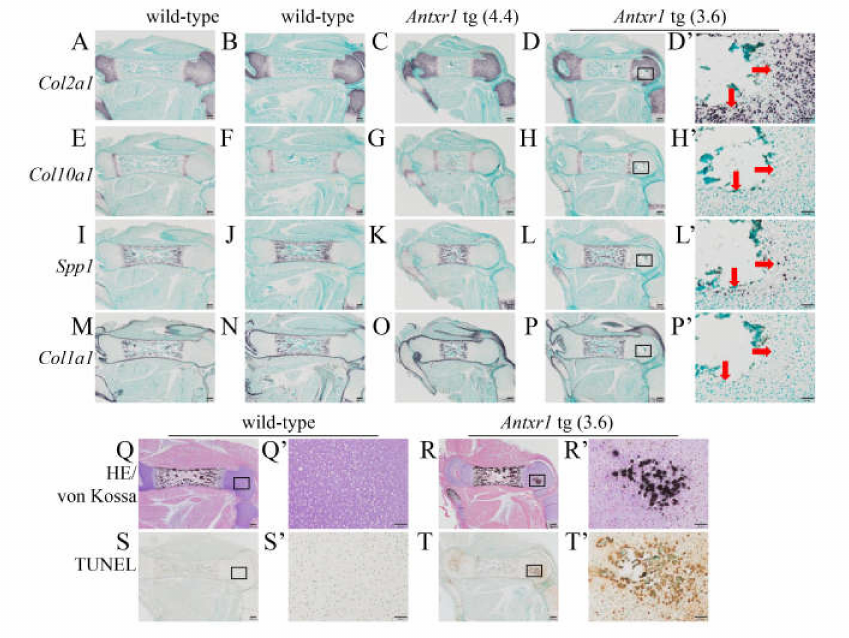
Figure 8. Histological analyses of wild-type and Antxr1 tg embryos at E18.5: ( A – P ) In situ hybridization using femoral sections from wild-type ( A , B , E , F , I , J , M , N ) and Antxr1 tg ( C , D , G , H , K , L , O , P ) F 0 embryos. Col2a1 ( A – D ), Col10a1 ( E – H ), Spp1 ( I – L ), and Col1a1 ( M – P ) anti-sense probes were used. The boxed regions in D , H , L , and P are magnified in D’ , H’ , L’ , and P’ , respectively. The arrows in D’ , H’ , L’ , and TUNEL staining ( S , T ) of wild-type ( Q , S ) and Antxr1 tg ( R , T ) F 0 embryos: The boxed regions expression levels in tg embryos are shown in parentheses. The number of embryos analyzed in situ hybridization, wild-type: 3, Antxr1 tg: 2; double staining of H-E and von Kossa, wild-type: 9, Antxr1 tg; 4; TUNEL staining, wild-type: 4, Antxr1 tg: 4. Similar results were obtained and the representative data are